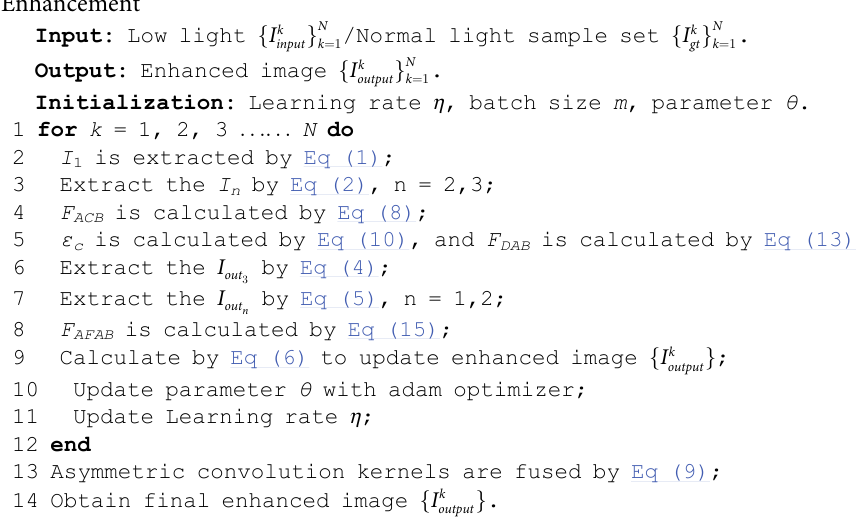
Algorithm 1: Efficient Adaptive Feature Aggregation Network for Low-light Image